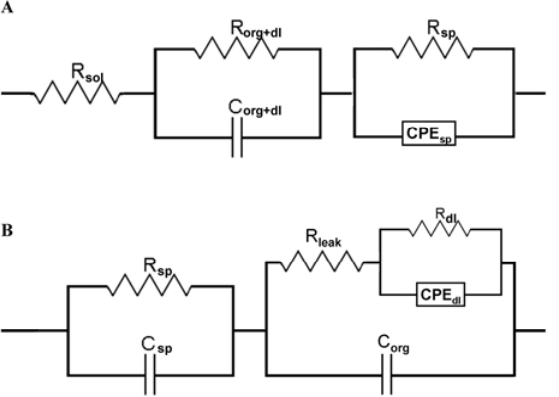
Figure 13. Electrical circuit models employed for the interpretation of impedance measurements. A: Model used by Yang and coworkers to interpret the effects at a DNA- modified semiconductor interface [34]. The equivalent circuit consists of a resistance R sp and a constant-phase element (CPE ) in parallel, representing the space-charge region in sp the diamond surface. The molecular layer, comprising the DNA and the linker layer, and the associated double-layer, are represented by a parallel configuration of a resistance and capacitance C . The resistance of the solution is represented by R . B: R org+dl org+dl sol Model used by Cai and coworkers to interpret the effects at a DNA-modified semiconductor interface [40]. The equivalent circuit consists of a resistance R and a sp capacitance C in parallel, representing the space-charge region in the silicon surface. The sp capacitor C represents the molecular layer, comprising the DNA and the linker layer. A org , reflects the penetration of the electrolyte through the molecular leakage resistance R leak layer. The electrical double-layer is represented by a CPE and a resistance R in dl dl